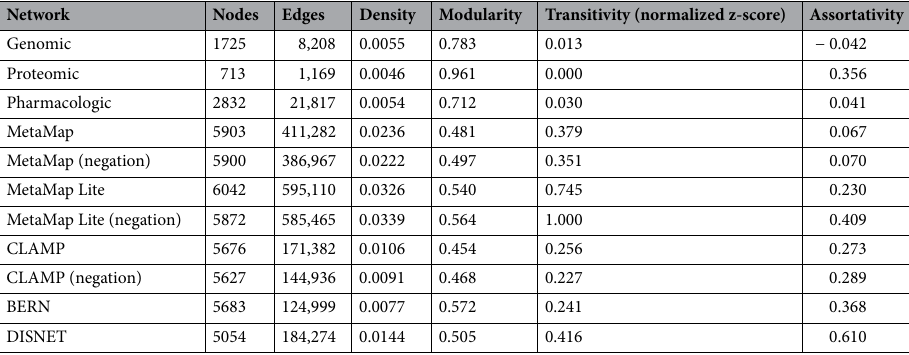
Table 1. Characteristics of the extracted networks. Calculations of the transitivity, including the results of the normality tests, are available in the Supplementary Materials (see Supplementary Table S1).